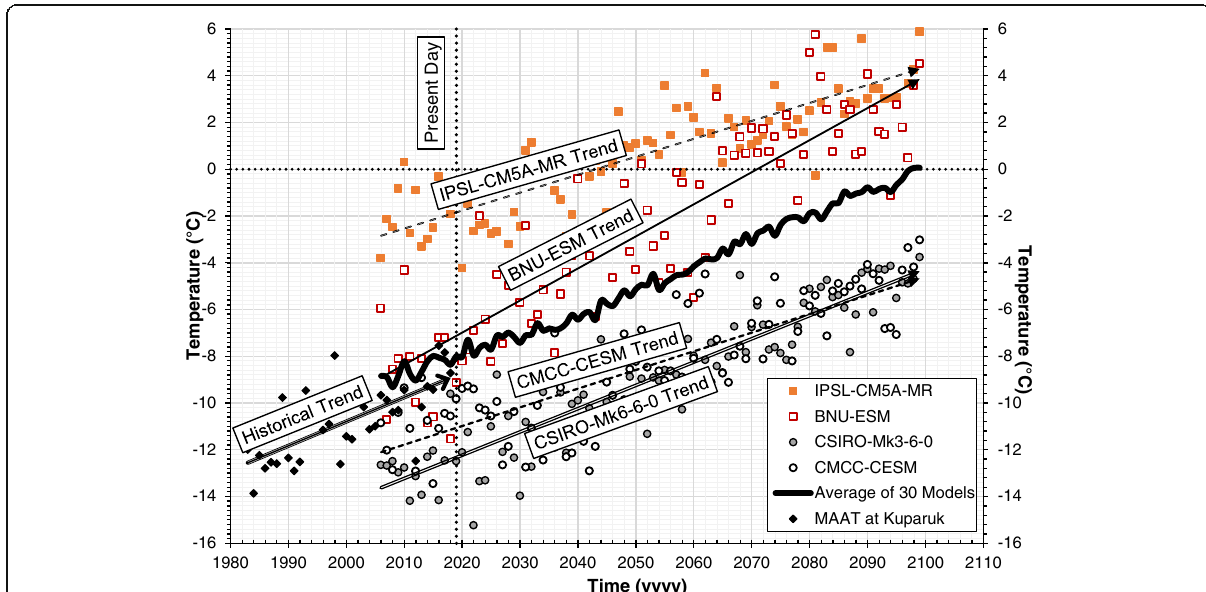
Fig. 4 Predicted mean annual air temperature of the upper and lower bounds of the 30 climate models showing trends of four models with historical and predicted averages